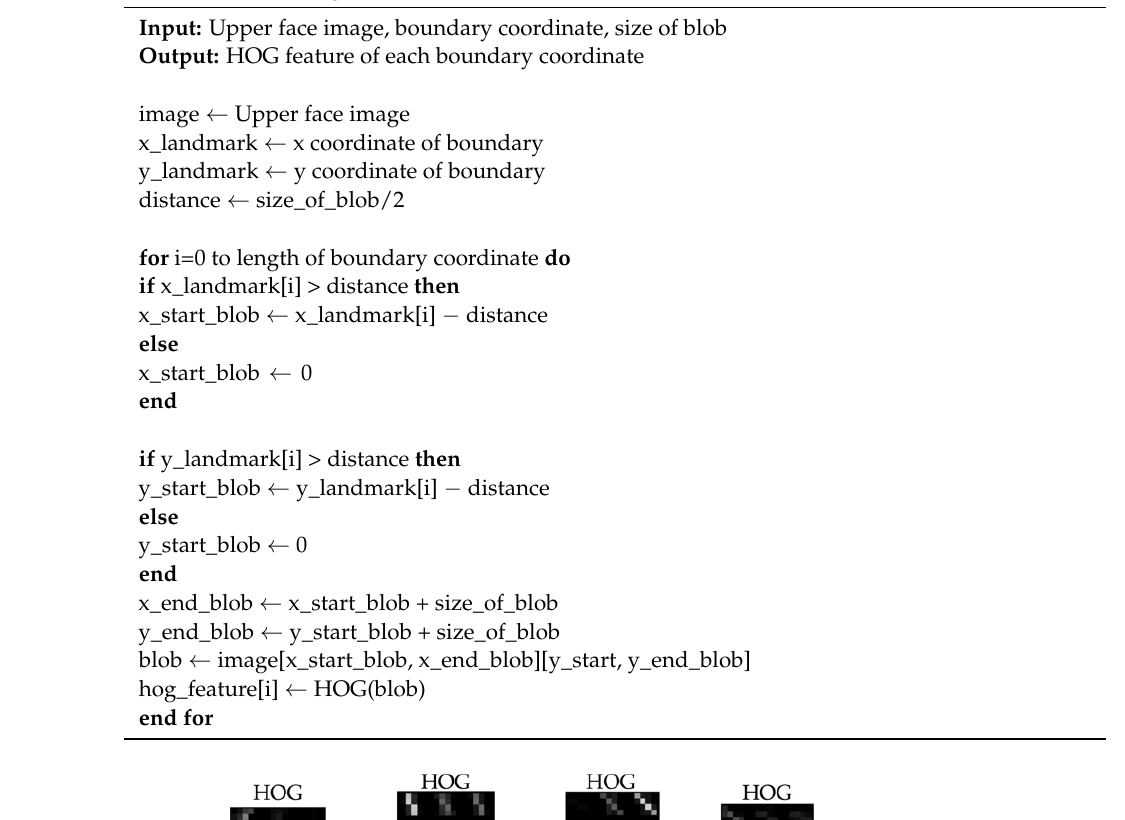
Algorithm 2: Histogram of Oriented Gradient (HOG)